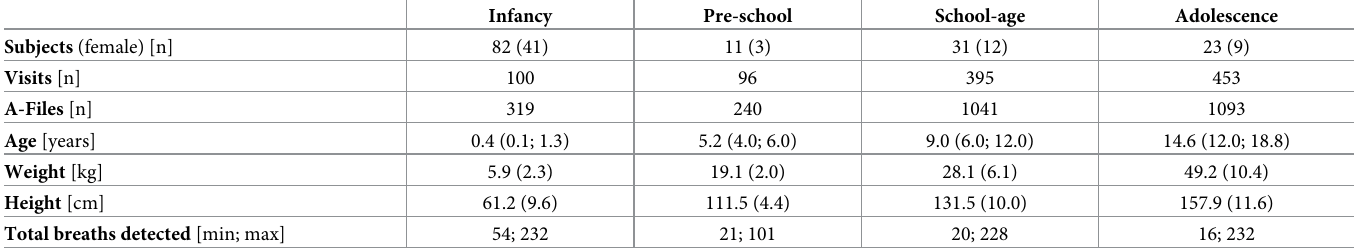
Table 1. Study population characteristics. Displayed as mean (SD) if not indicated otherwise. A-Files are text files that contain raw data on flow, oxygen, carbon dioxide, and molar mass signals of a multiple-breath washout test. Age on test date as mean (min; max), total breaths detected by Spiroware 3.3.1 (min;